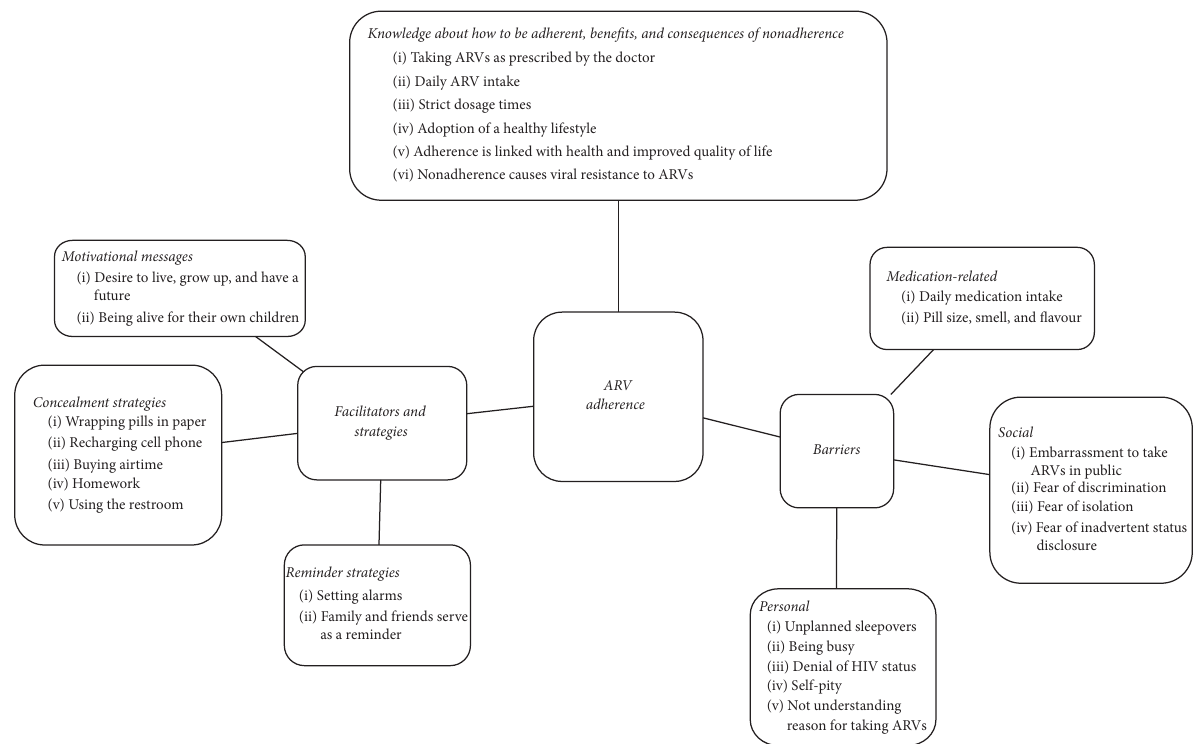
Figure 1: Summary of themes and subthemes emerging from FGDs and